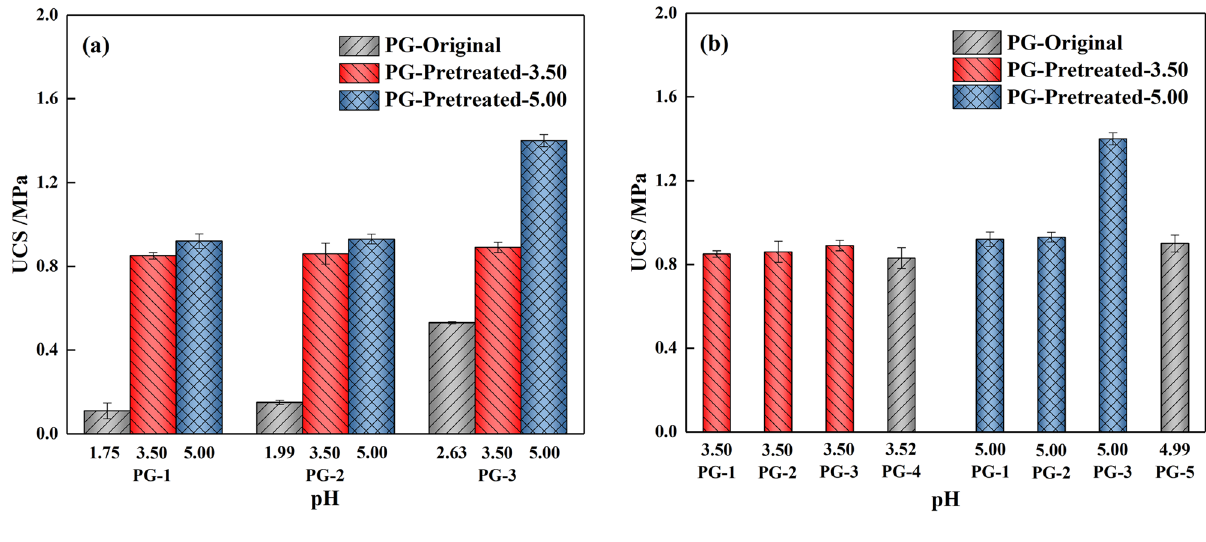
Figure 9. Unconfined compressive strength of 28d backfill prepared by PG with and without pretreatment.